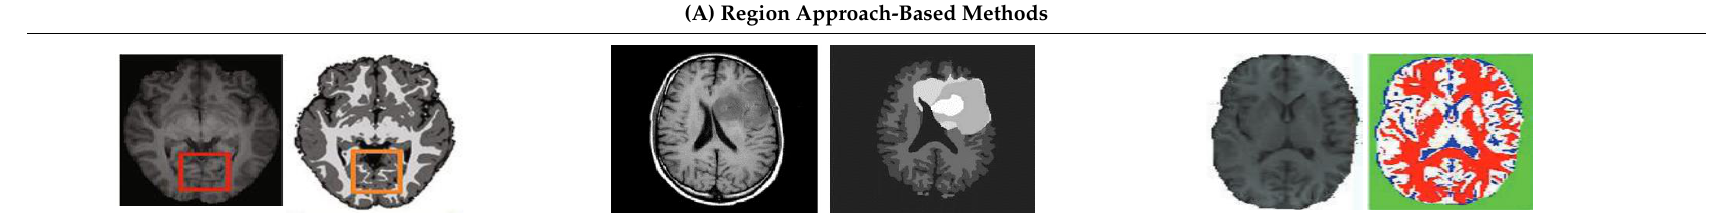
MRI brain segmentation using Convolutional Neural Networks (CNN): (left) Original image, (right) Results of segmentation; illustration reproduced with the permission of Springer Nature [39].